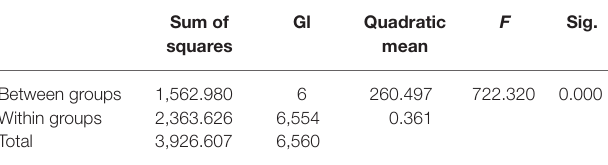
TABLE 7 | ANOVA test between cognitive level and type of